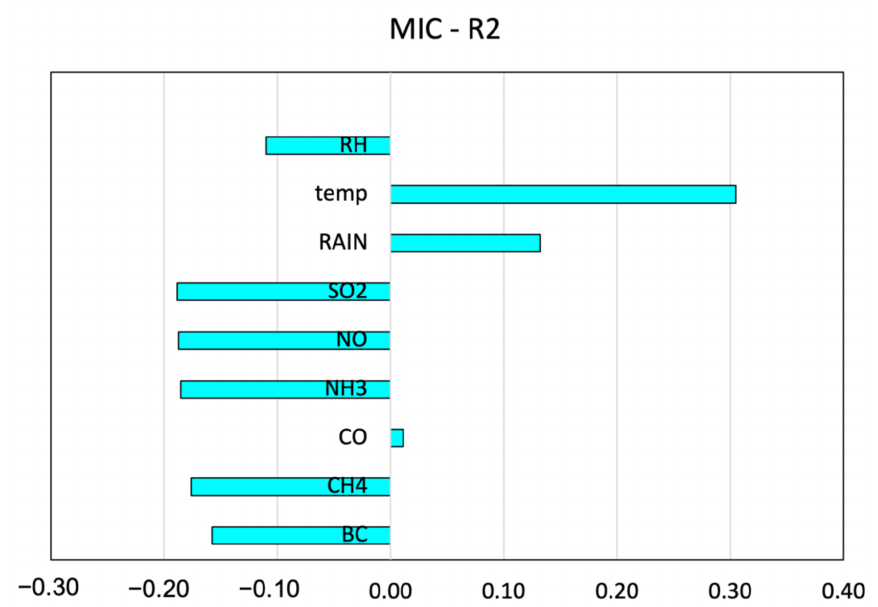
Figure 8. The difference between MIC—R 2 of emission and climate parameter and PM 2.5 during